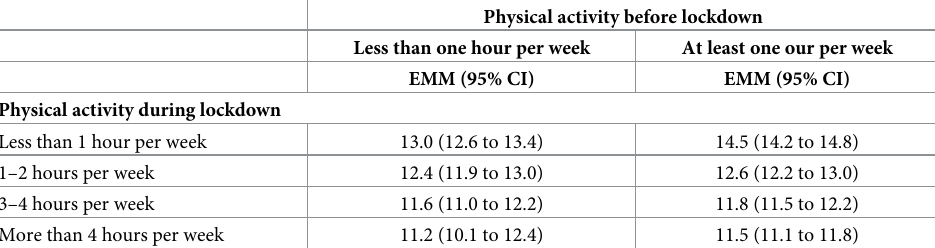
Table 3. HADS estimated marginal means (EMMs) by levels of physical